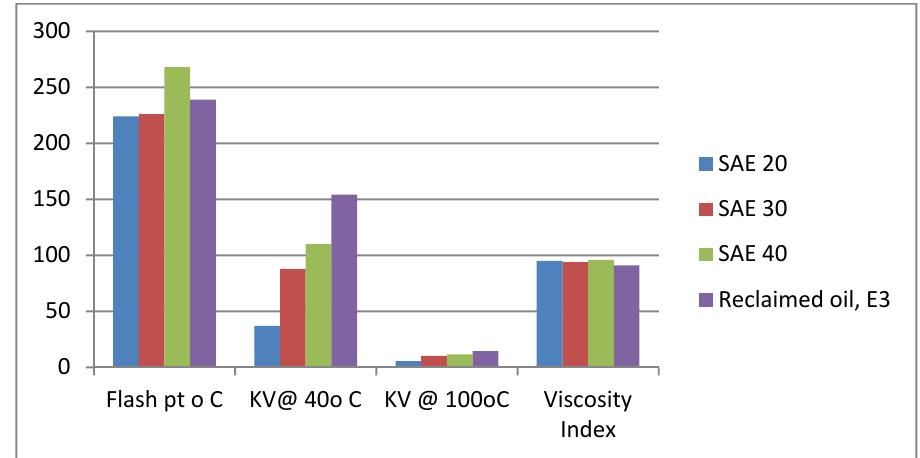
Figure 5. Comparison between SAE20, SAE 30, SAE 40 and reclaimed oil (E3).